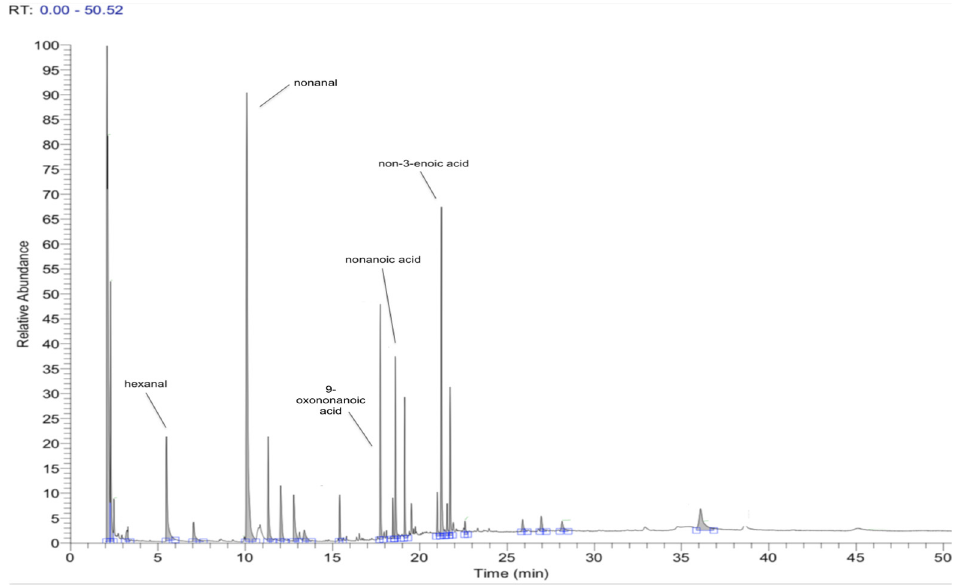
Figure 2. The results of GC-MS analysis of olive oil after ozonation (0.1 mole O 3 /100 g oil).